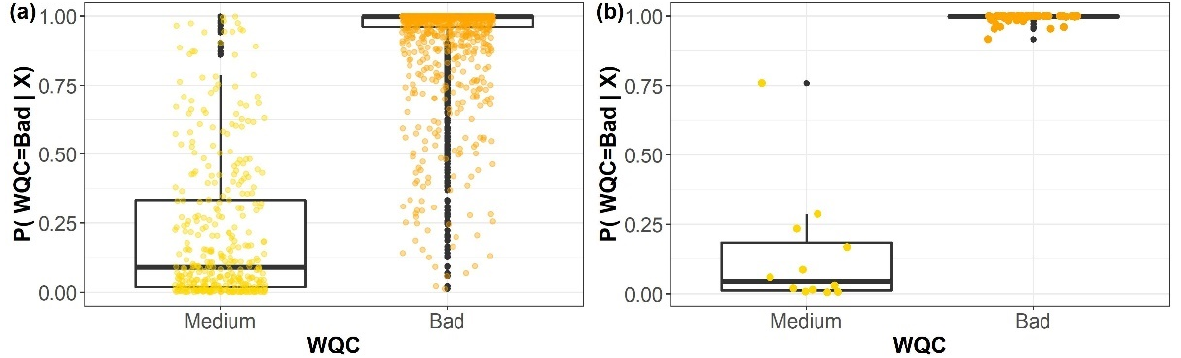
Figure 13. Conditional probability of the classified observations for ( a ) the training data set and ( b )